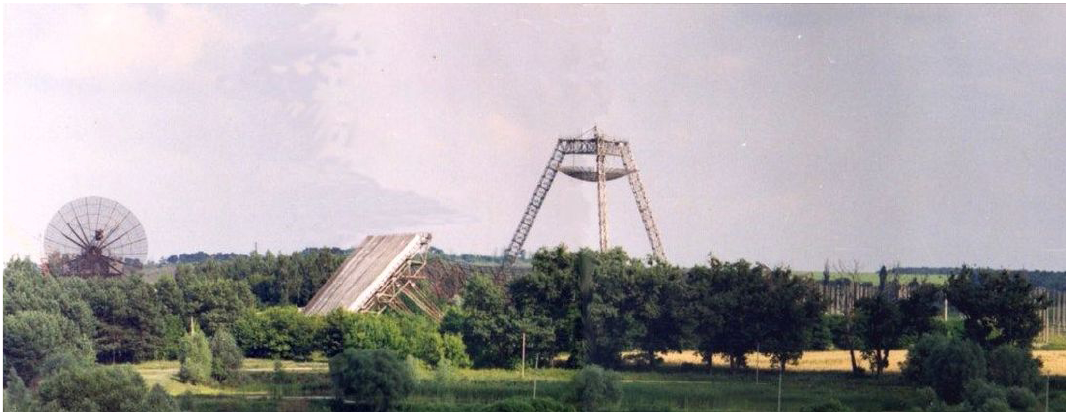
Figure 9. The Observatory of